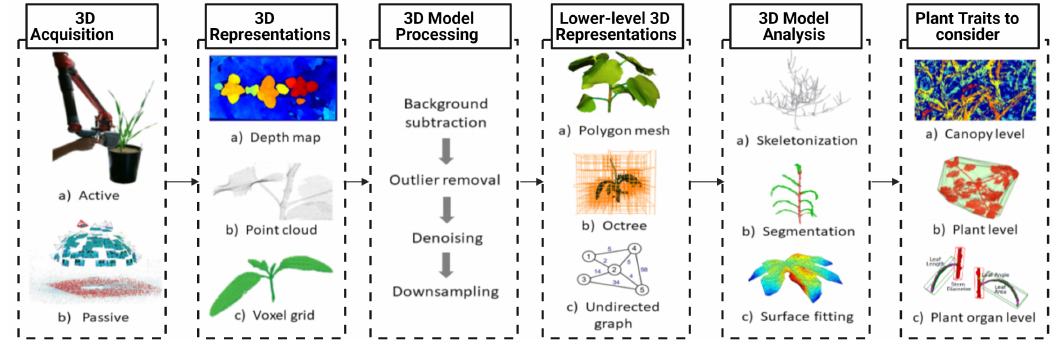
Figure 2. Outline of processing and analysis stages for 3D plant growth monitoring.